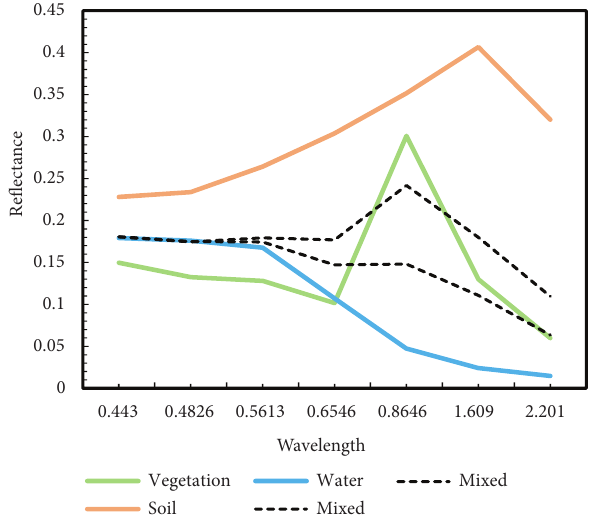
Figure 3. Spectral signatures of the three selected endmembers with reflection of mixed pixels